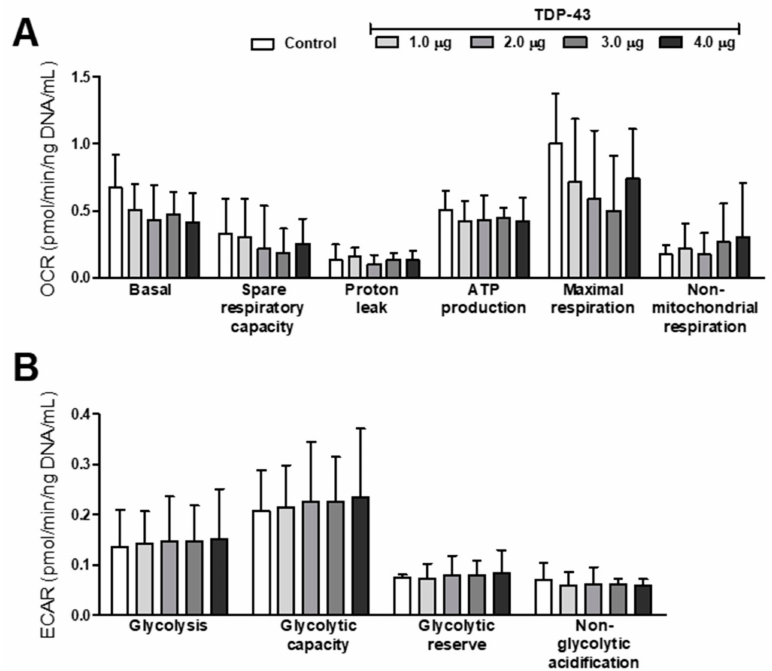
Figure 5. TDP-43 overexpression induces dose-dependent trends of modifications in energy metabolism. ( A ) Oxygen consumption rate (OCR); ( B ) Extracellular acidification rate (ECAR). Data are presented as mean ± SEM. Statistical analysis revealed no di ff erences between groups (Kruskal–Wallis nonparametric test; n =